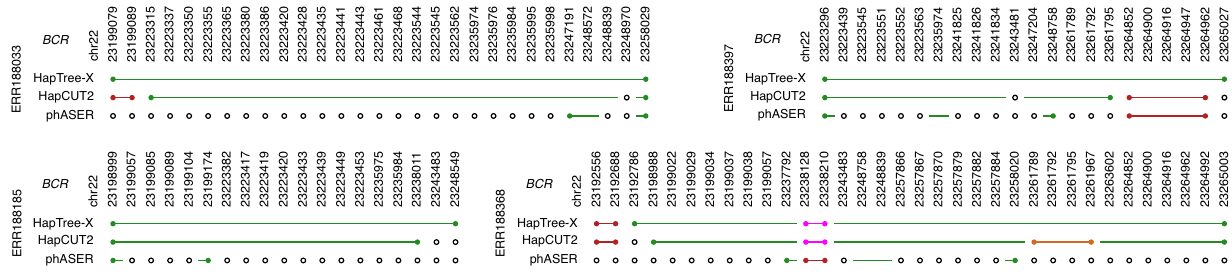
Fig. 3 Phasing of the BCR gene by HapTree-X, HapCUT2, and phASER on a selection of four GEUVADIS RNA-seq samples. Unphased SNPs are represented by an empty circle, and each phased block is given a unique color. Reported SNP loci are relative to the human genome hg19